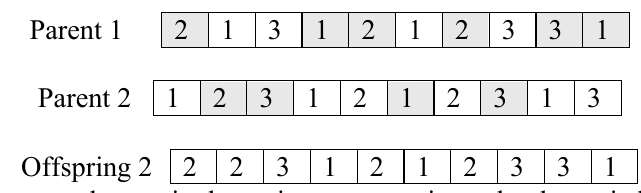
Fig. 5. Uniform crossover: each gene in the assignment part is randomly copied from the same gene of either parent 1 or parent 2